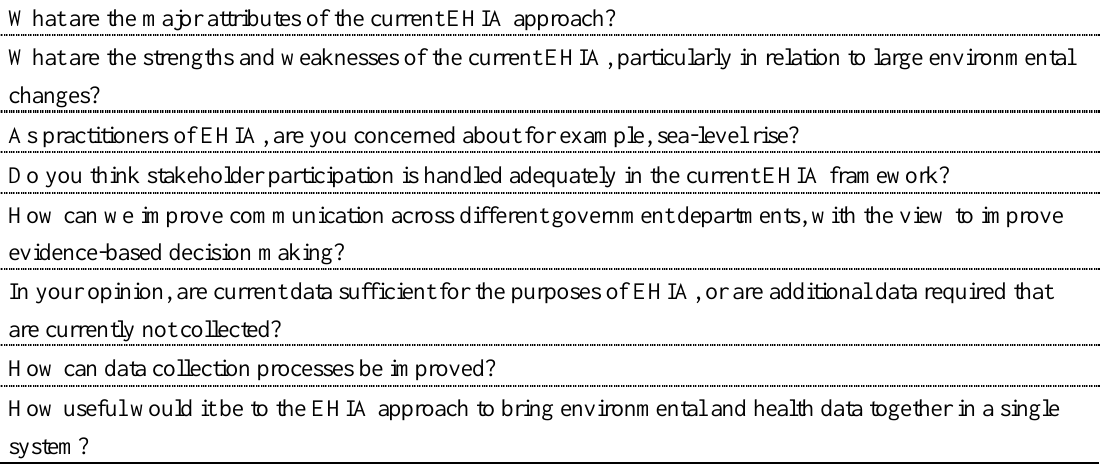
Table 2. List of the primary questions for focus groups’